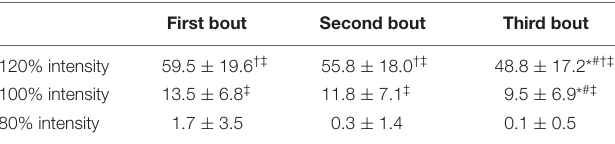
TABLE 1 | Stretching pain changes during three stretching interventions in three different stretching